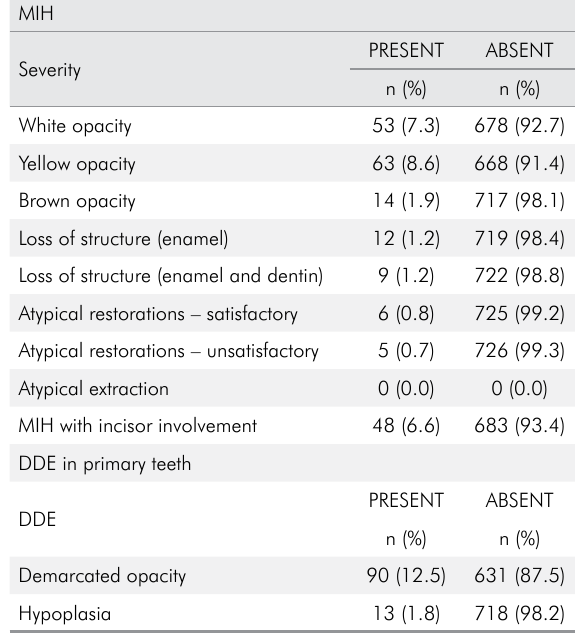
Table 2. Prevalence of molar incisor hypomineralization (MIH) and developmental defects of enamel (DDE) in primary teeth according to severity (Curitiba, Brazil,